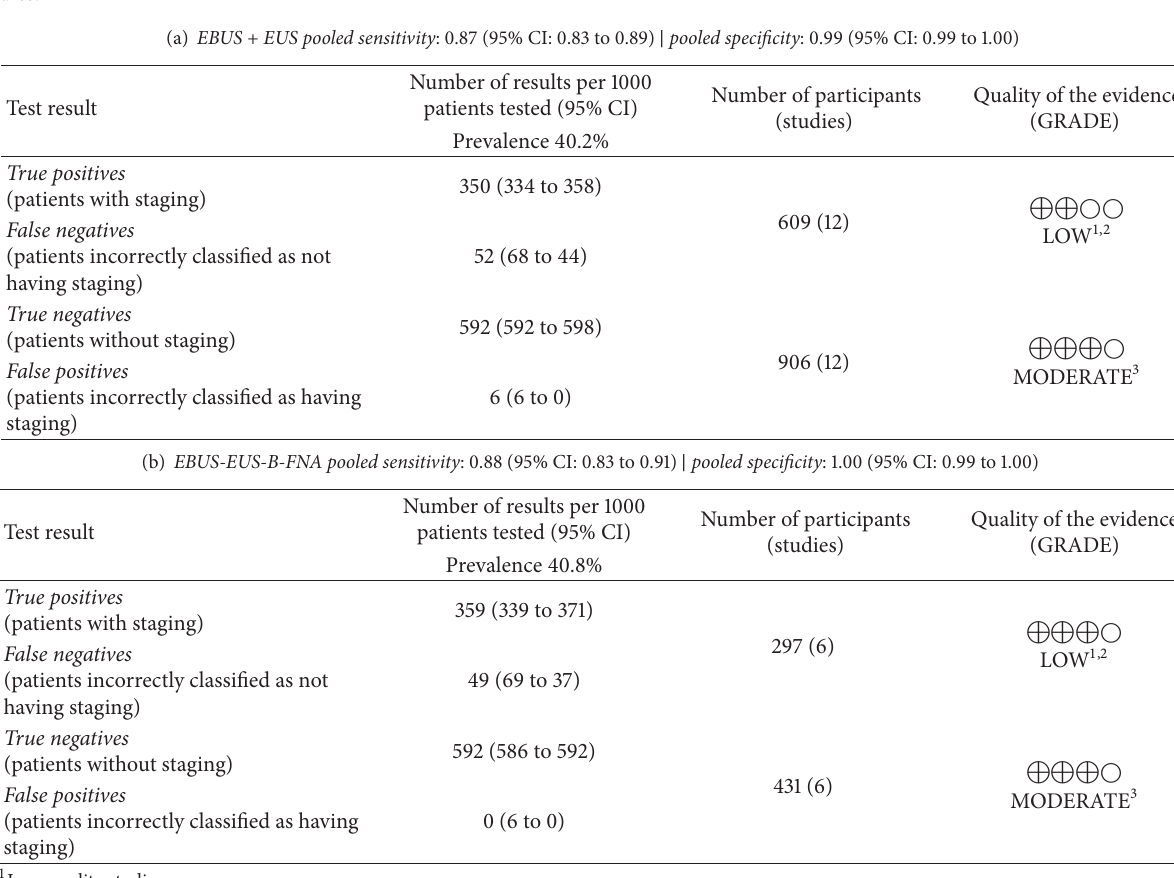
Table 4: Summary of finding using GRADE approach. (a) shows EBUS + EUS-B-FNA only; (b) shows pooled data from all included primary